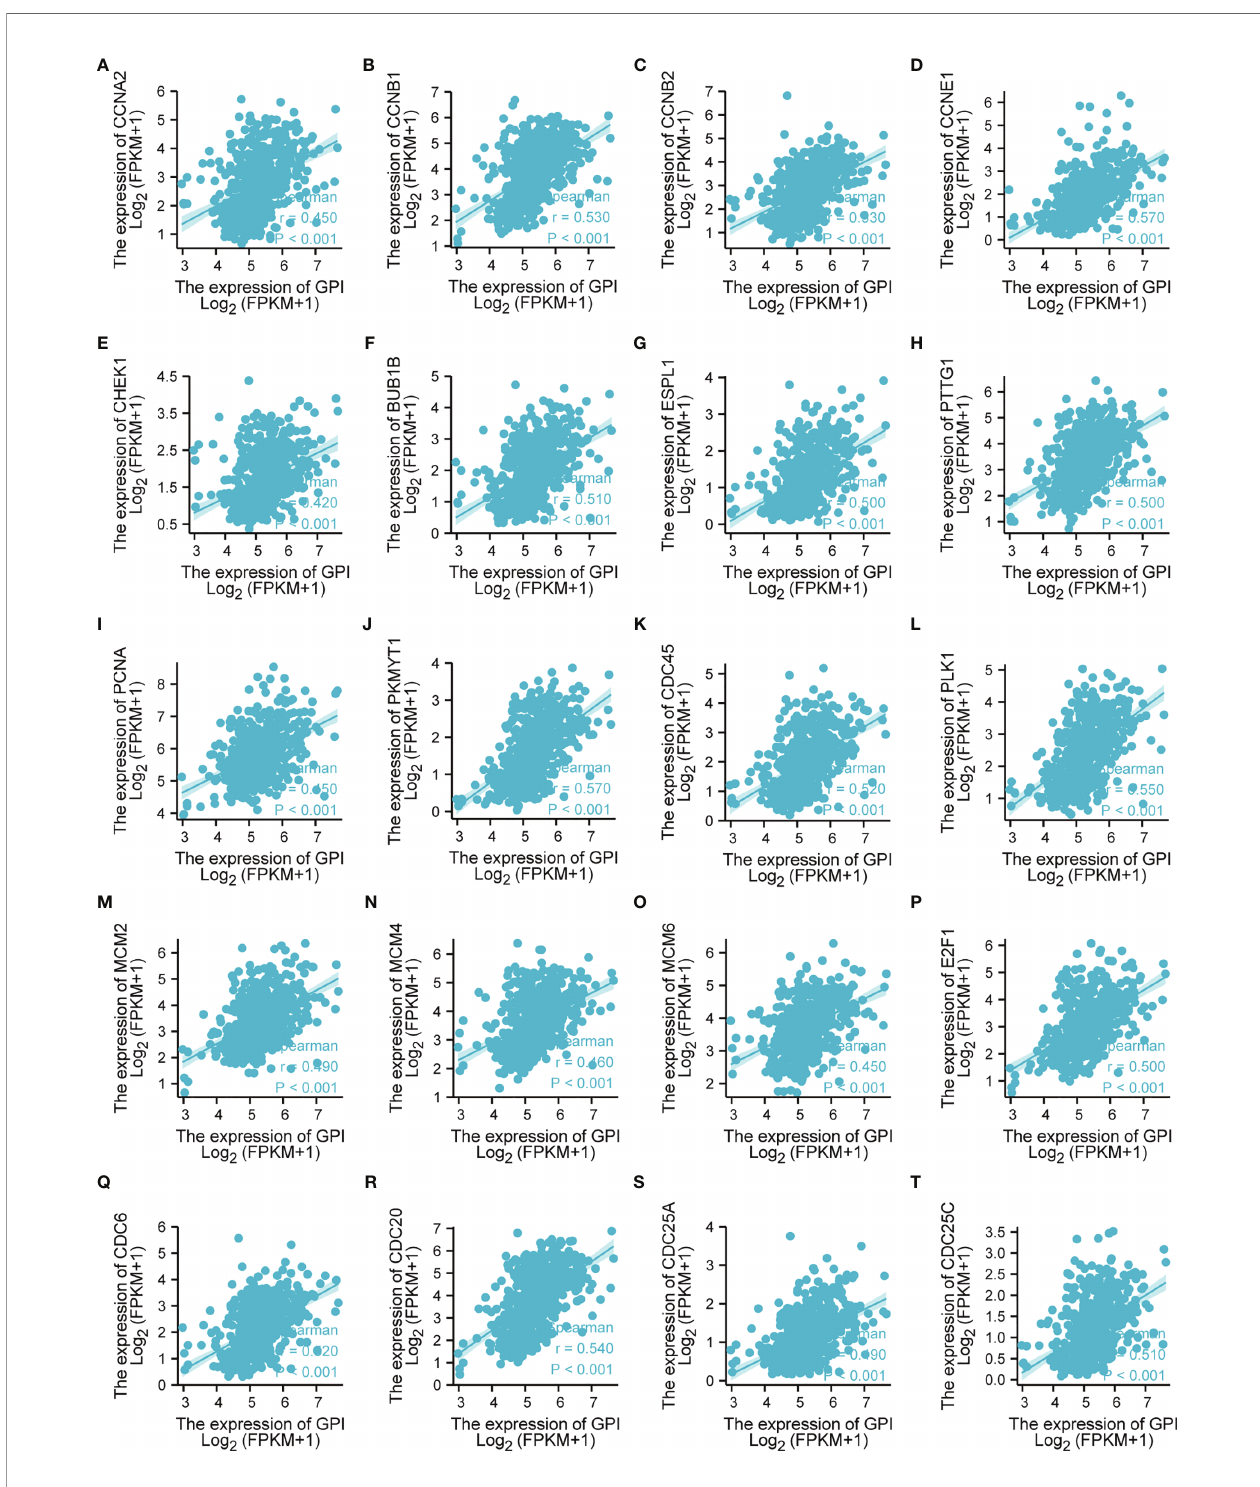
FIGURE 10 | Correlation analysis between glucose-6-phosphate isomerase (GPI) and the cell cycle regulatory genes in lung adenocarcinoma (LUAD) in The Cancer Genome Atlas (TCGA). (A) CCNA2, (B) CCNB1, (C) CCNB2, (D) CCNE1, (E) CHEK1, (F) BUB1B, (G) ESPL1, (H) PTTG1, (I) PCNA, (J) PKMYT1, (K) CDC45, (L) PLK1, (M) MCM2, (N) MCM4, (O) MCM6, (P) E2F1, (Q) CDC6, (R) CDC20, (S) CDC25A, and (T)